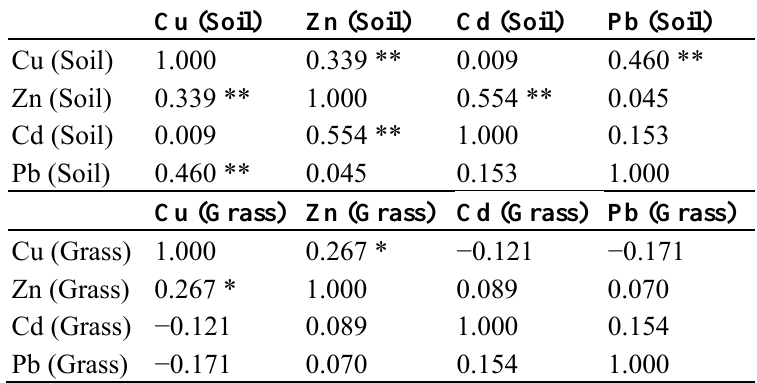
Table 6. Correlation Analyses of Cu, Zn, Cd, and Pb Concentrations for Soil and Grass Samples, Respectively.